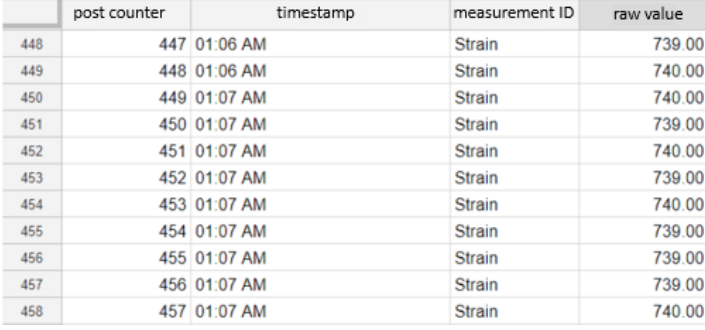
Figure 19. Google spreadsheet with 11 readings (stored in the cloud) coming from the smart strain